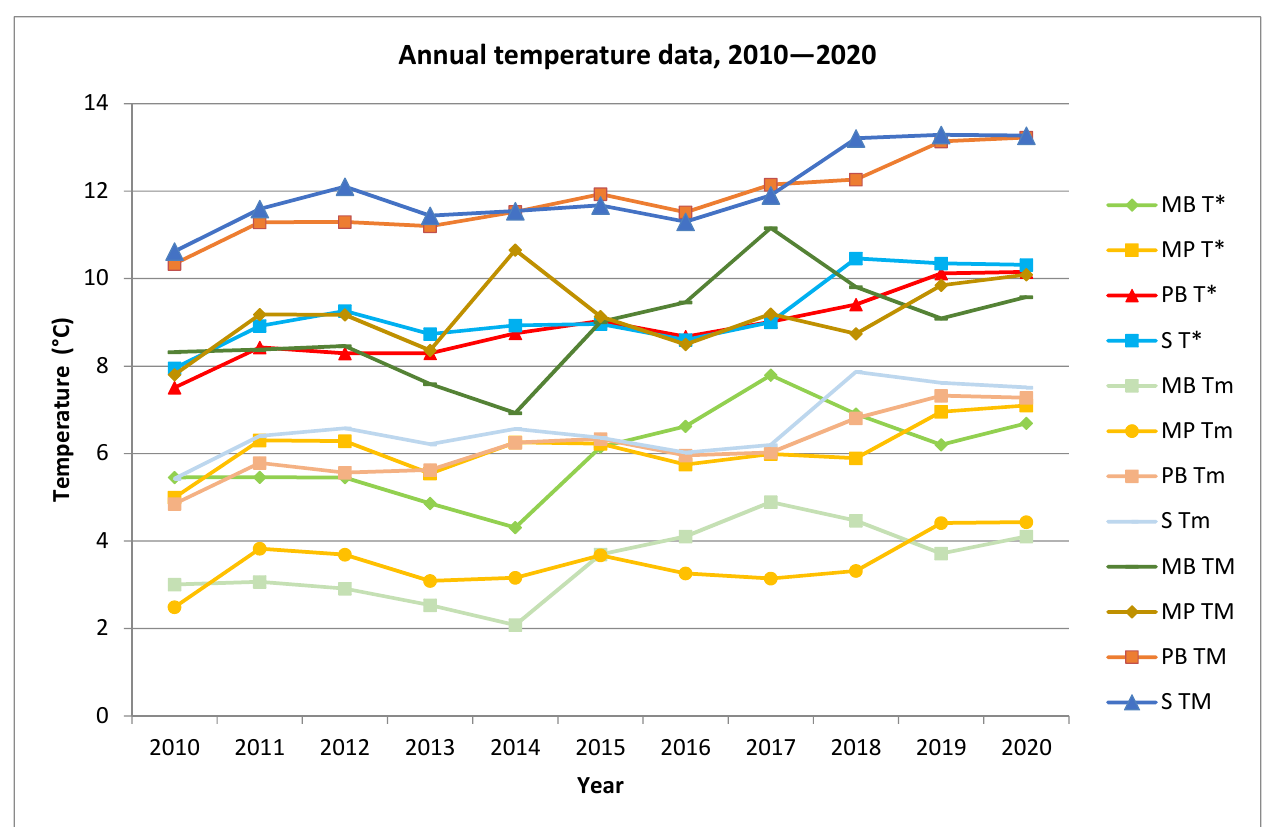
Figure 4. Graph of annual data of T, Tm, and TM, for all analysed stations (MB, MP, PB, S).